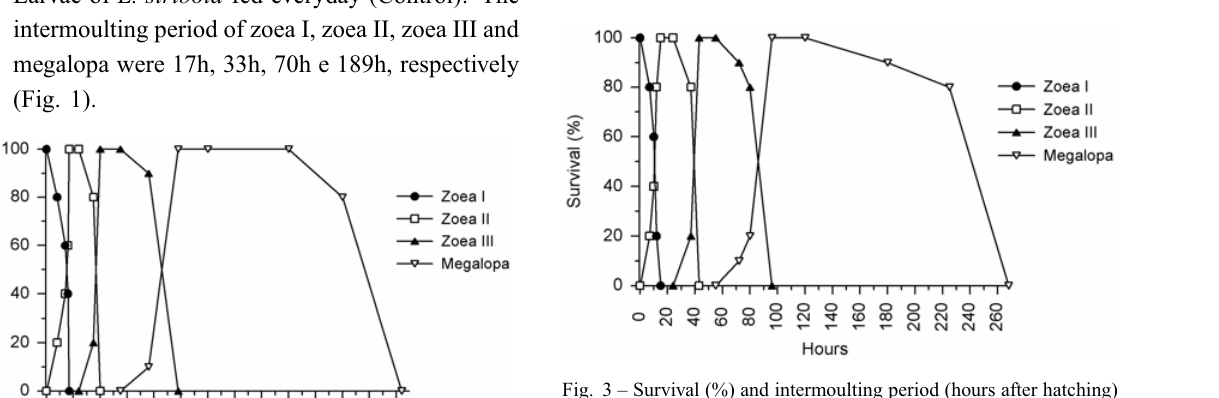
Fig. 3 – Survival (%) and intermoulting period (hours after hatching) of Lepidophthalmus siriboia larvae reared in the laboratory and sub- mitted to an initial feeding period. In this treatment, they were fed during 2 days only.